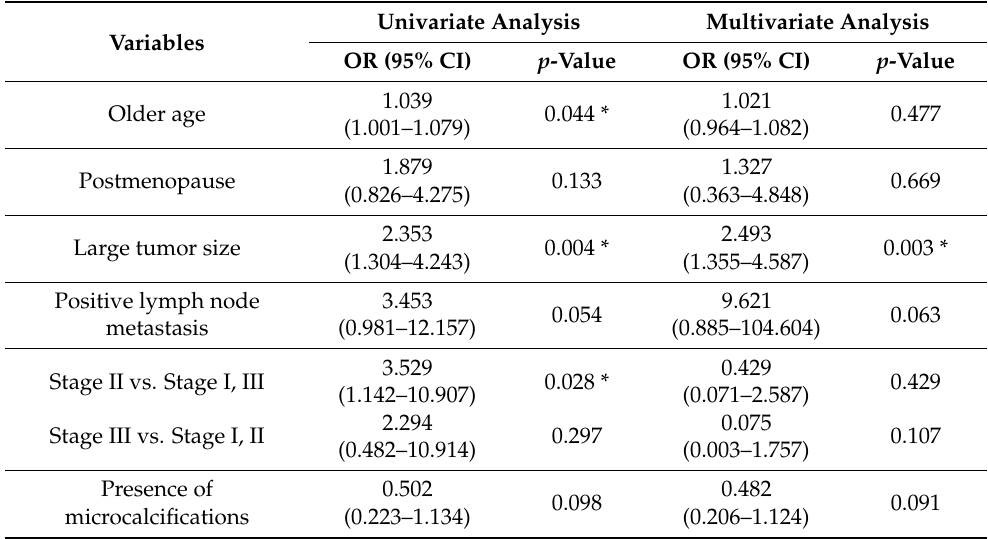
Table 3. Univariate and multivariate analysis of association between positive elastographic finding and clinicopathological characteristics.